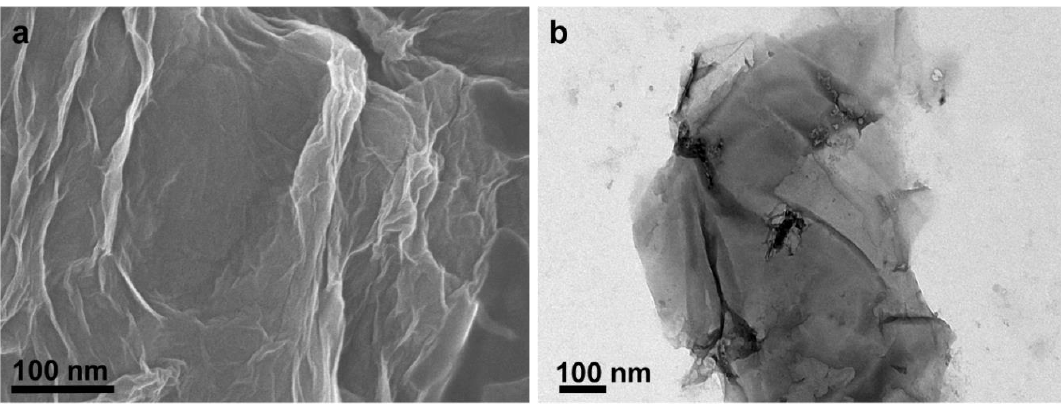
Figure 2. ( a ) Field emission scanning electron microscope (FESEM) and ( b ) transmission electron microscopic (TEM) images of synthesized graphene oxide (GO).